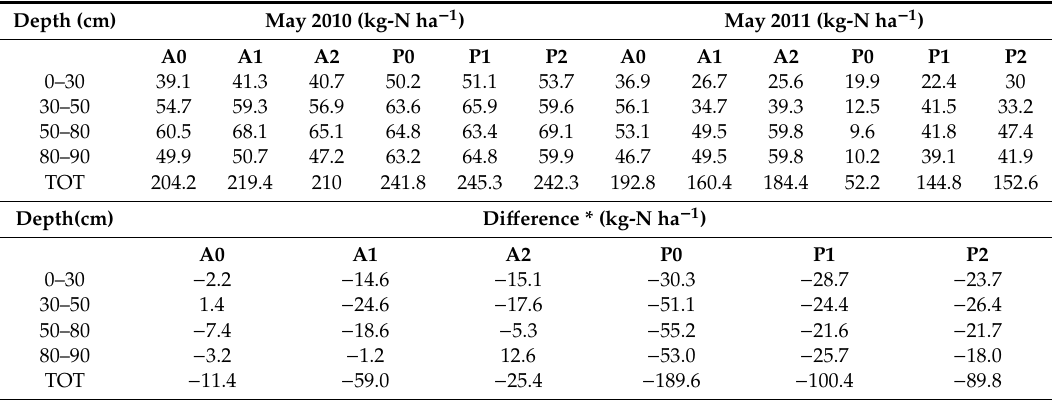
Table 4. Concentration of N in soil.